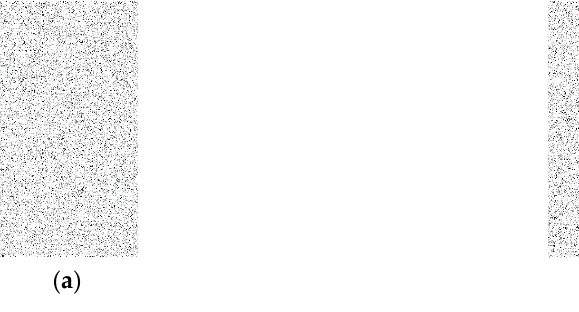
Figure 5. ( a ) is the completely random cases; ( b ) is from a weak technique.